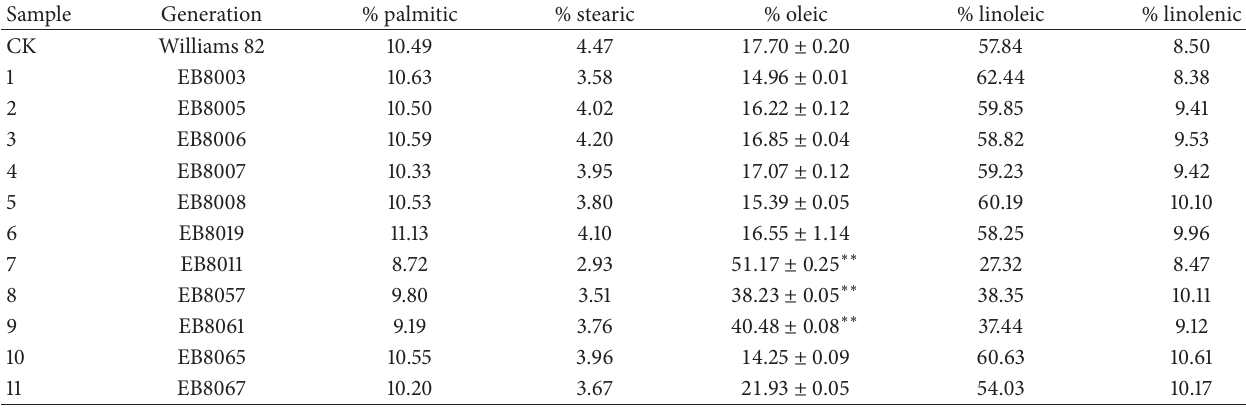
Table 3: GC-MS results yielding the oil composition of the transgenic soybean seed line. Sample